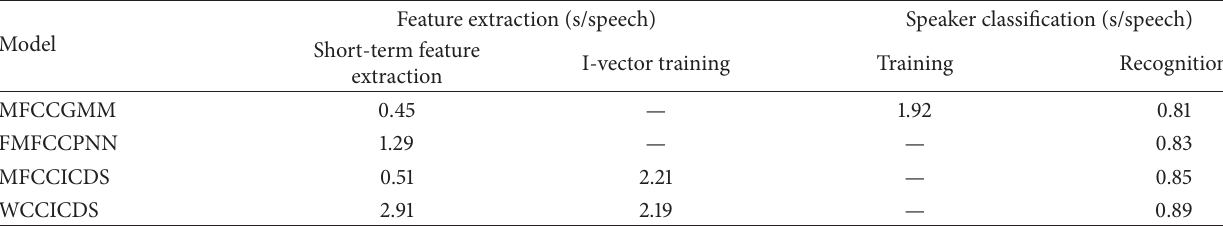
Table 4: Average time cost of the speaker recognition